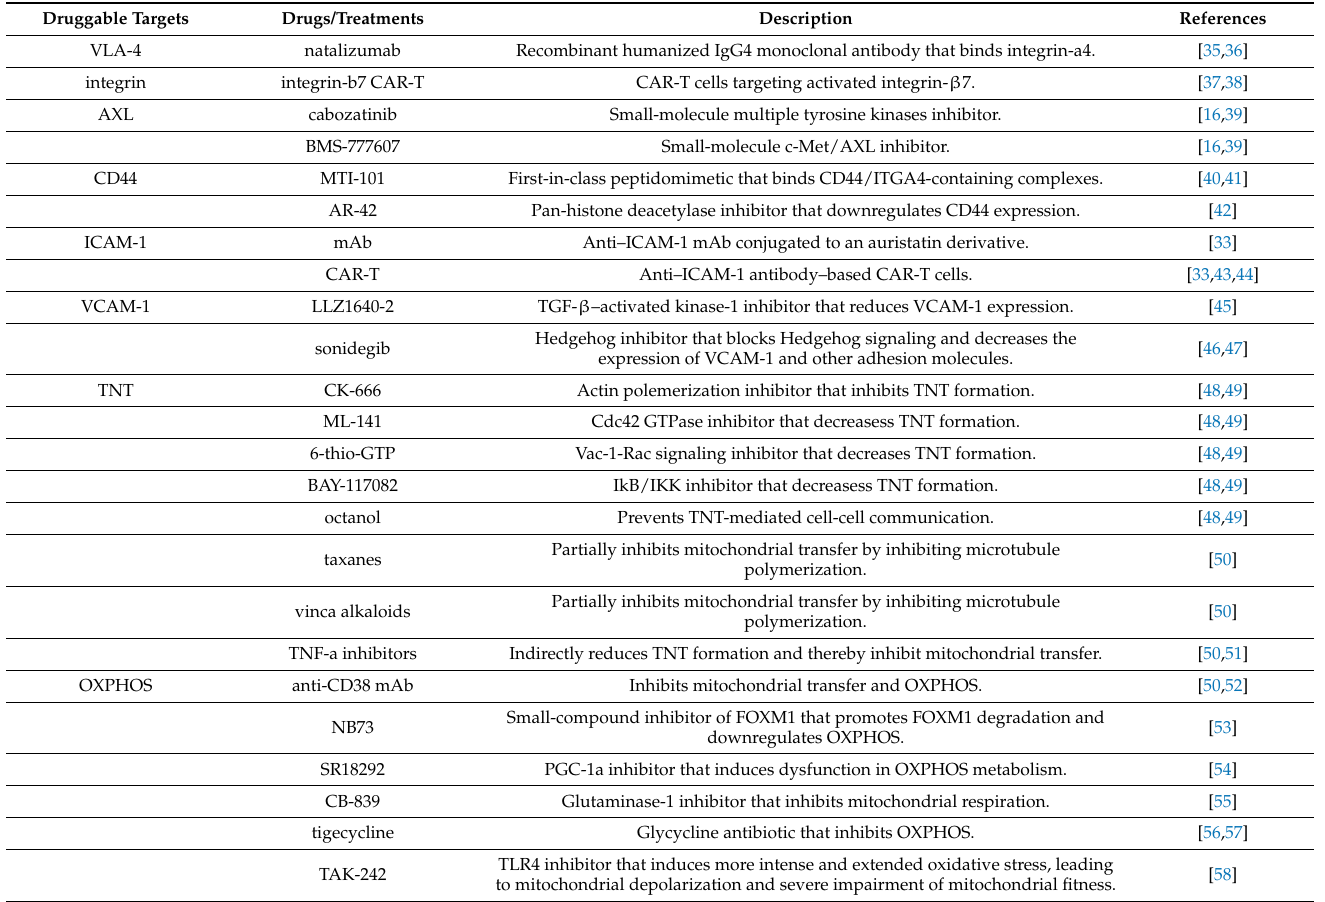
Table 1. Summary of drugs/treatments targeting CAM-DR, OXPHOS, and